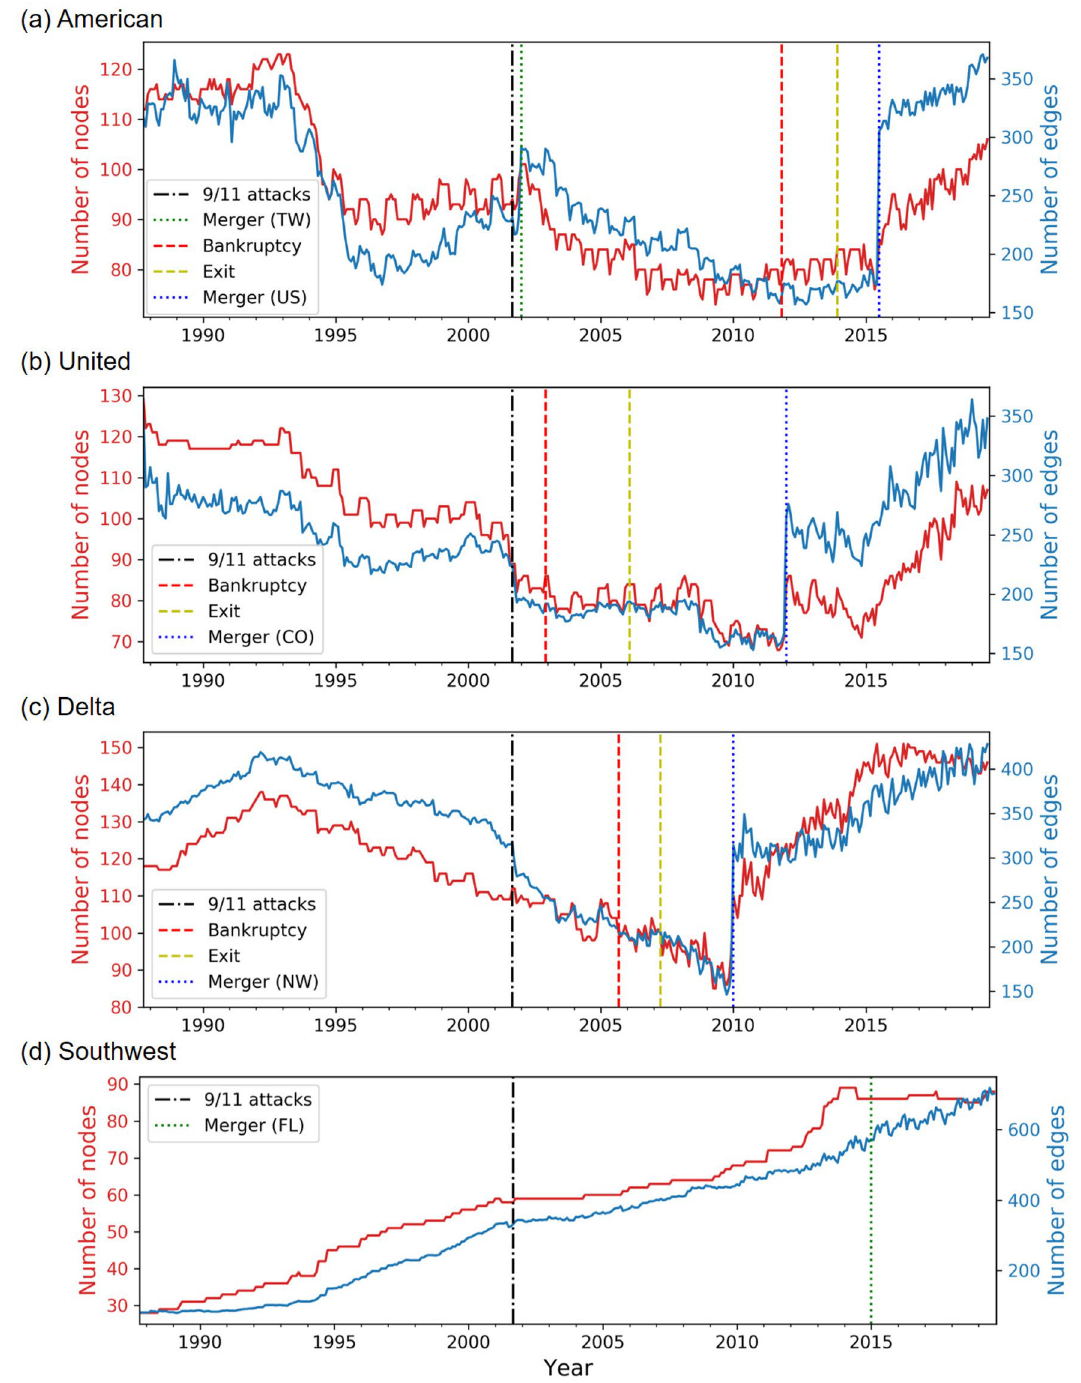
Figure 1. Evolution of the numbers of nodes and edges over time. ( a ) American Airlines, ( b ) United Airlines, ( c ) Delta Air Lines, and ( d ) Southwest binarized to 0. In our framework, we analyze the original values of the network distances without binarizing them, which enables us to reveal various patterns in the distance matrices without varying a threshold parameter. Third, we notice that the distance matrix for WN (Fig. 2d) has many bright horizontal and vertical stripes after 1995. They suggest that WN has frequently changed their network, but for a short duration each time such as a single month. In Fig. 3, we show the box plots of the distribution of the network distance between pairs of months. Each box plot summarizes each distance matrix shown in Fig. 2. To be quantitative, we carry out statistical analyses on these distributions. First, we carry out the Kruskal–Wallis test to find that there is a significant difference among the four distributions shown in Fig. 3 ( p < 0.001 ). Second, as a post-hoc test, we run the Bonferroni-corrected